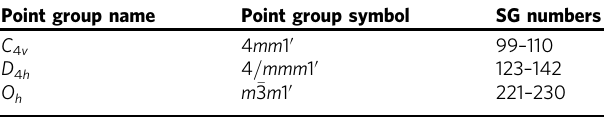
Table 2 Space groups (SGs) that admit Dirac points with HOFA states derived from the QI introduced in ref. 23